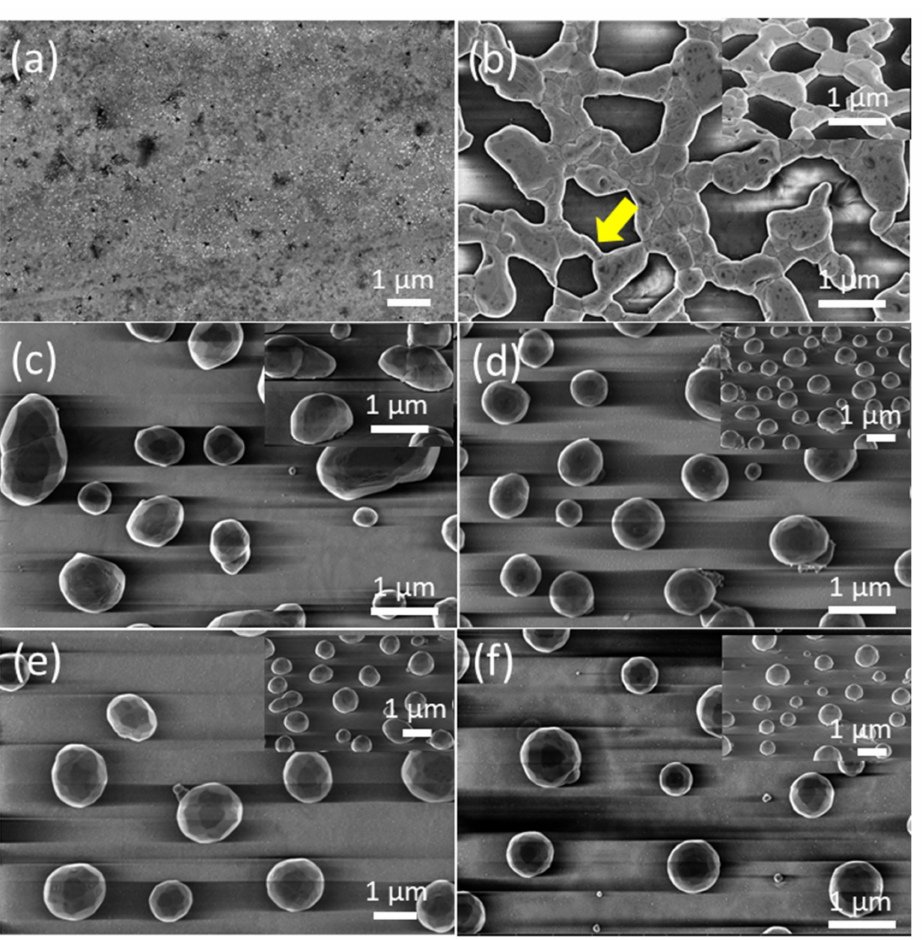
Figure 4. Top views of the FE-SEM micrographs of vacuum-thermal-evaporated silver layers with a nominal thickness d Ag =80 nm at different stages of the annealing step during the SSD process apply- ing the heat-up region program depicted in Figure 1 and ending at different T A values: ( a ) as-grown silver layer, ( b ) T A = 250 ◦ C, ( c ) T A = 300 ◦ C, ( d ) T A = 350 ◦ C, ( e ) T A =400 ◦ C, and ( f ) T A = 500 ◦ C. The insets depict the corresponding tilted FE-SEM micrograph views (with a tilt angle of 52 ◦ ). The yellow arrow in ( b ) highlights specific features of the dewetting process, leading to the formation of the silver nanoparticles. Temperature ramp rate =10 ◦ C /min. In all cases, a soda lime glass substrate has been